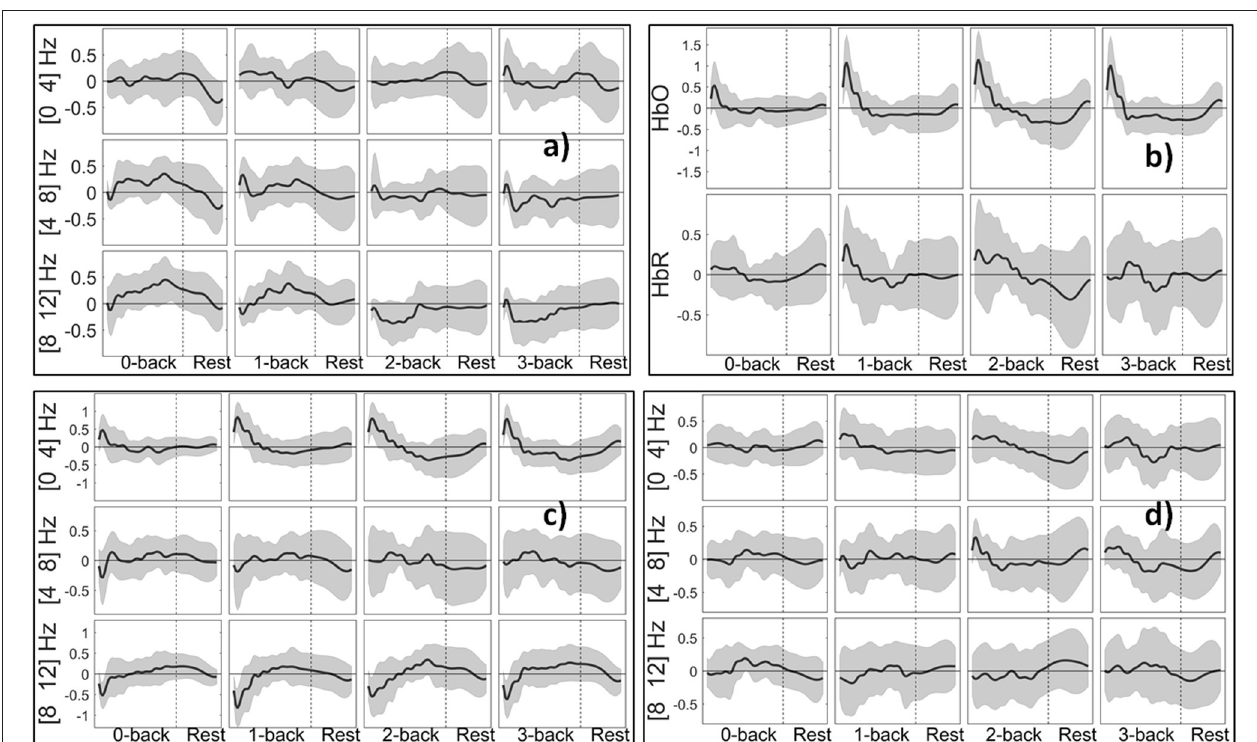
FIGURE 9 | Grand block average of normalized features from 5s windows: (a) PSD (delta, theta, alpha bands) of channel O2. (b) HbO/R Amp. for channel 10. (c) NVO (delta, theta, alpha bands) for channel 10. (d) NVR features (delta, theta, alpha bands) for channel 10. Shaded areas indicate the standard deviation of inter-subject